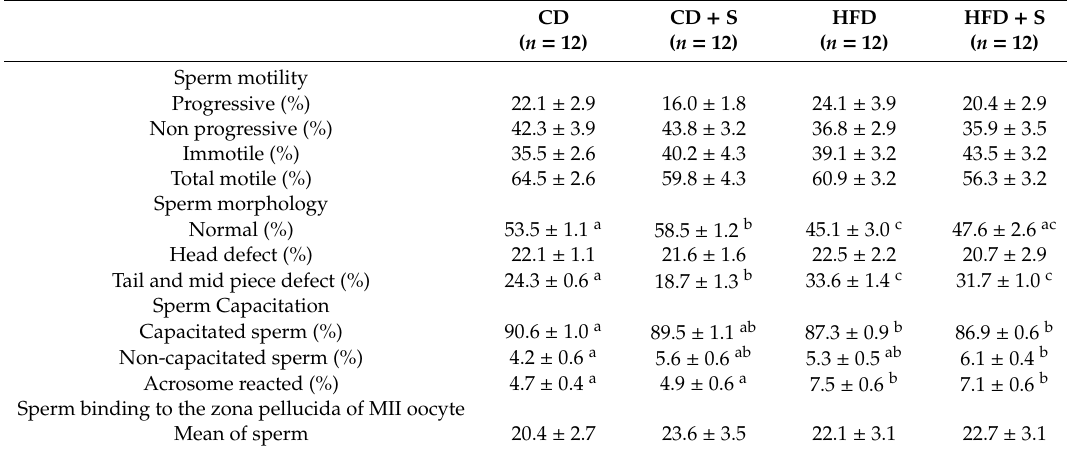
Table 3. The e ff ect of diet and short-term micronutrient supplementation on sperm motility, morphology, capacitation, and binding to the zona pellucida of MII